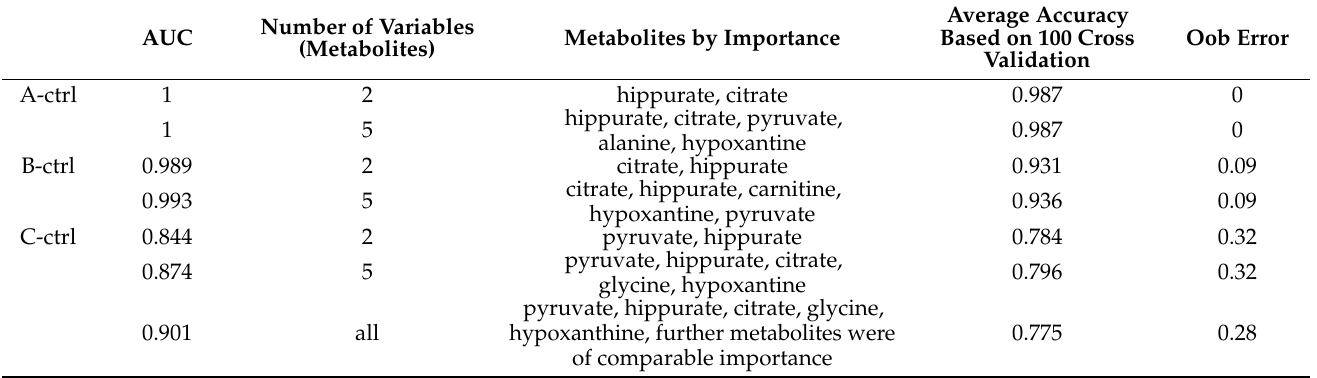
Figure 2. PCA analyzes patients with COVID–19 disease at three various sampling times (Day 1, red; Day 5 − 8, orange; Day 29 − 54, blue) and controls (green). ( A ) All three sampling times together, ( B ) Day 1 against controls; ( C ) Day 5–8 against controls, ( D ) day 29–54 against controls. The relative concentrations of metabolites in urine were used as input variables for the algorithm. Table 3. Result from binary discrimination by random forest algorithm, the relative levels of urinary metabolites were used as the input